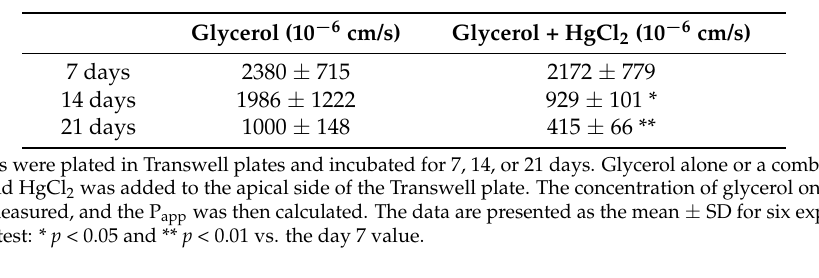
Table 1. P app of glycerol during Caco-2 cell